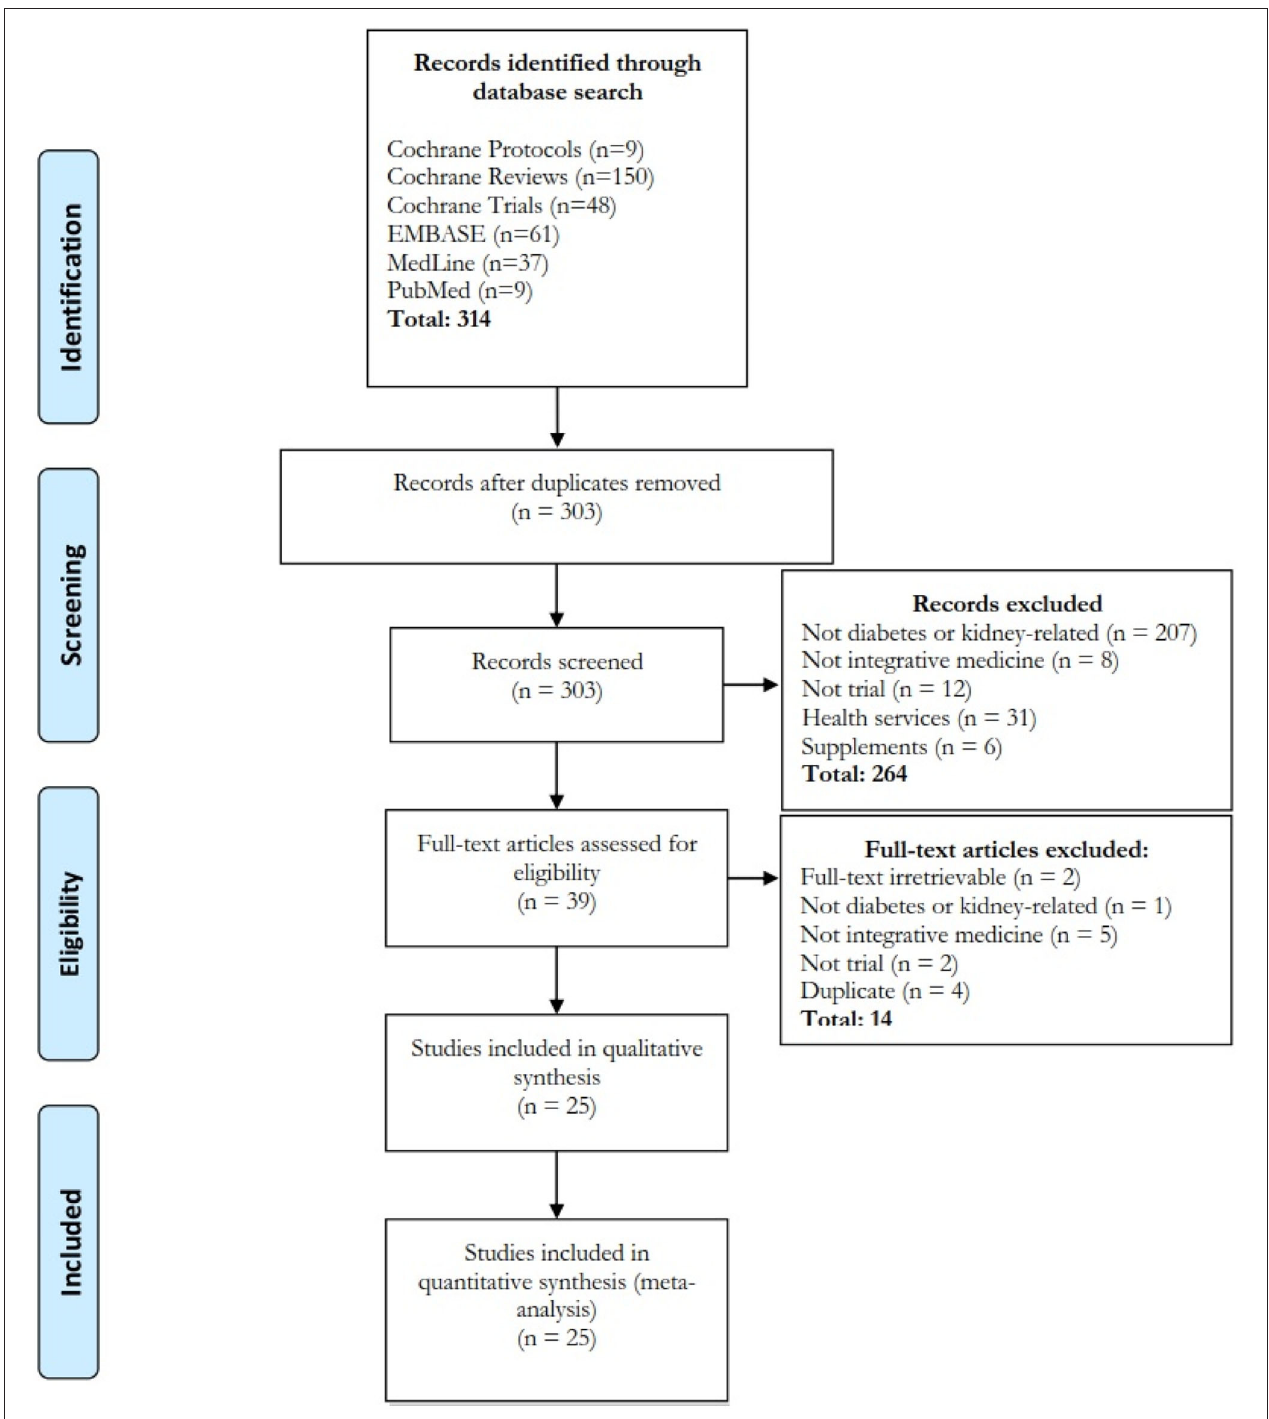
FIGURE 2 | Flow diagram of systematic review. Four databases and search engines were searched and 25 papers were included. Interventions included acupuncture/acupressure ( n = 7), herbal products ( n = 14), massage-related ( n = 2), qigong ( n = 1) and combined acupuncture-herbal ( n = 1) treatment. The treatment was formulated according to Chinese ( n = 20), Kampo ( n = 2), Korean ( n = 1), Ayurvedic ( n = 1), and western herbal ( n = 1) medicine.